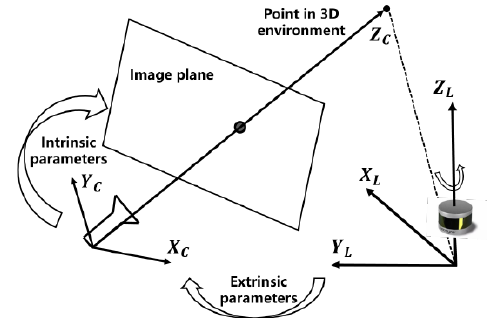
Figure 1: Representation of the process of camera imaging and